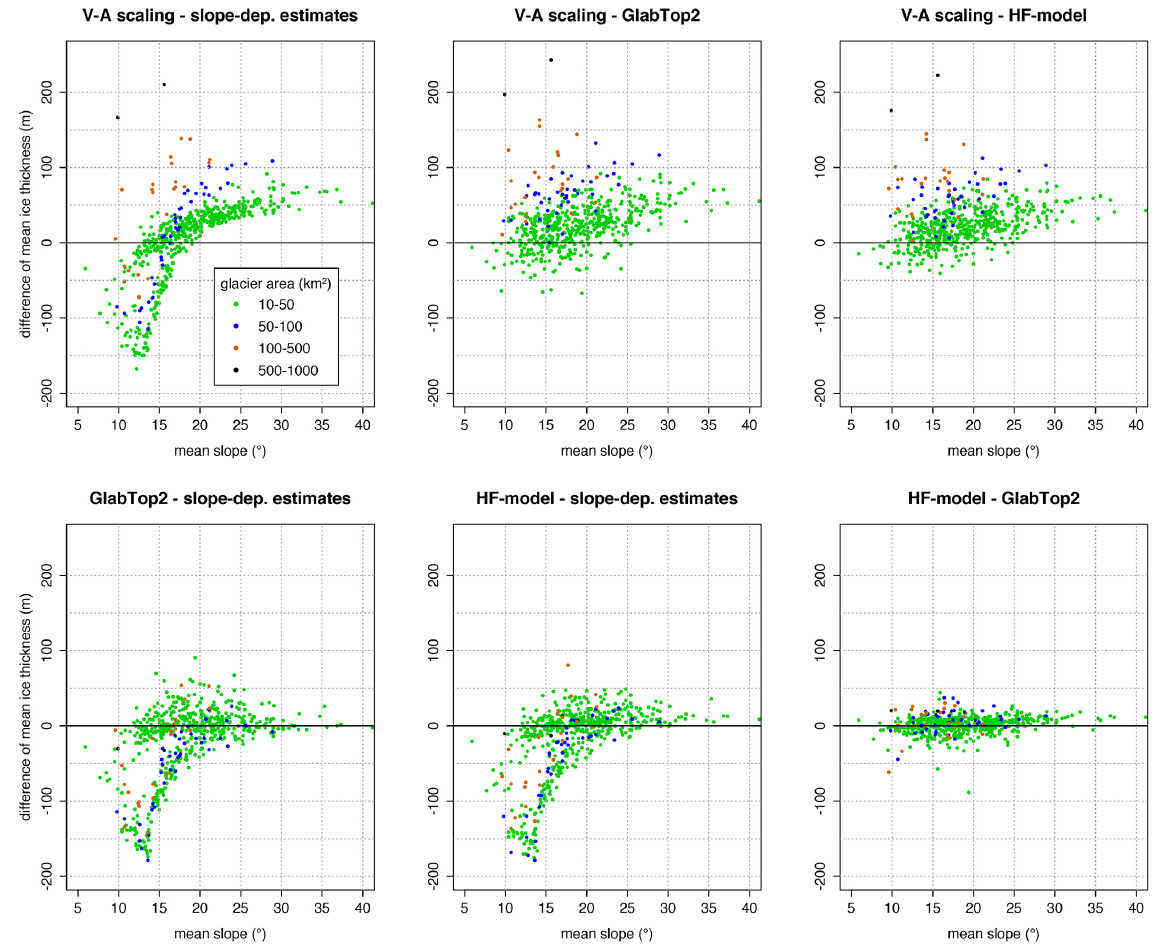
Figure 10. Differences of mean ice-thicknesses from all approaches, plotted against mean slope. All HK glaciers larger than 10km 2 are considered, they hold about 75% of the entire glacier volume. For V–A scaling, results from the Bahr et al. (1997) approach are used because these numbers represent about the average from the different V–A approaches applied